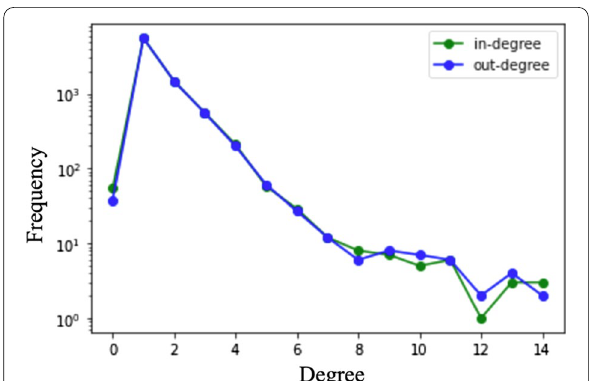
Fig. 6 Degree distribution of the multimodal transport